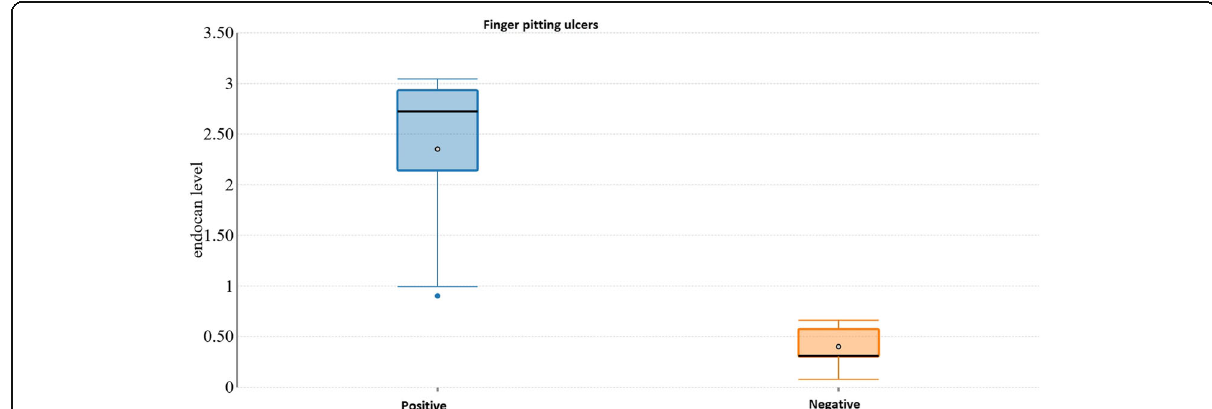
Fig. 2 Box plot of endocan level in patients with and without finger pitting